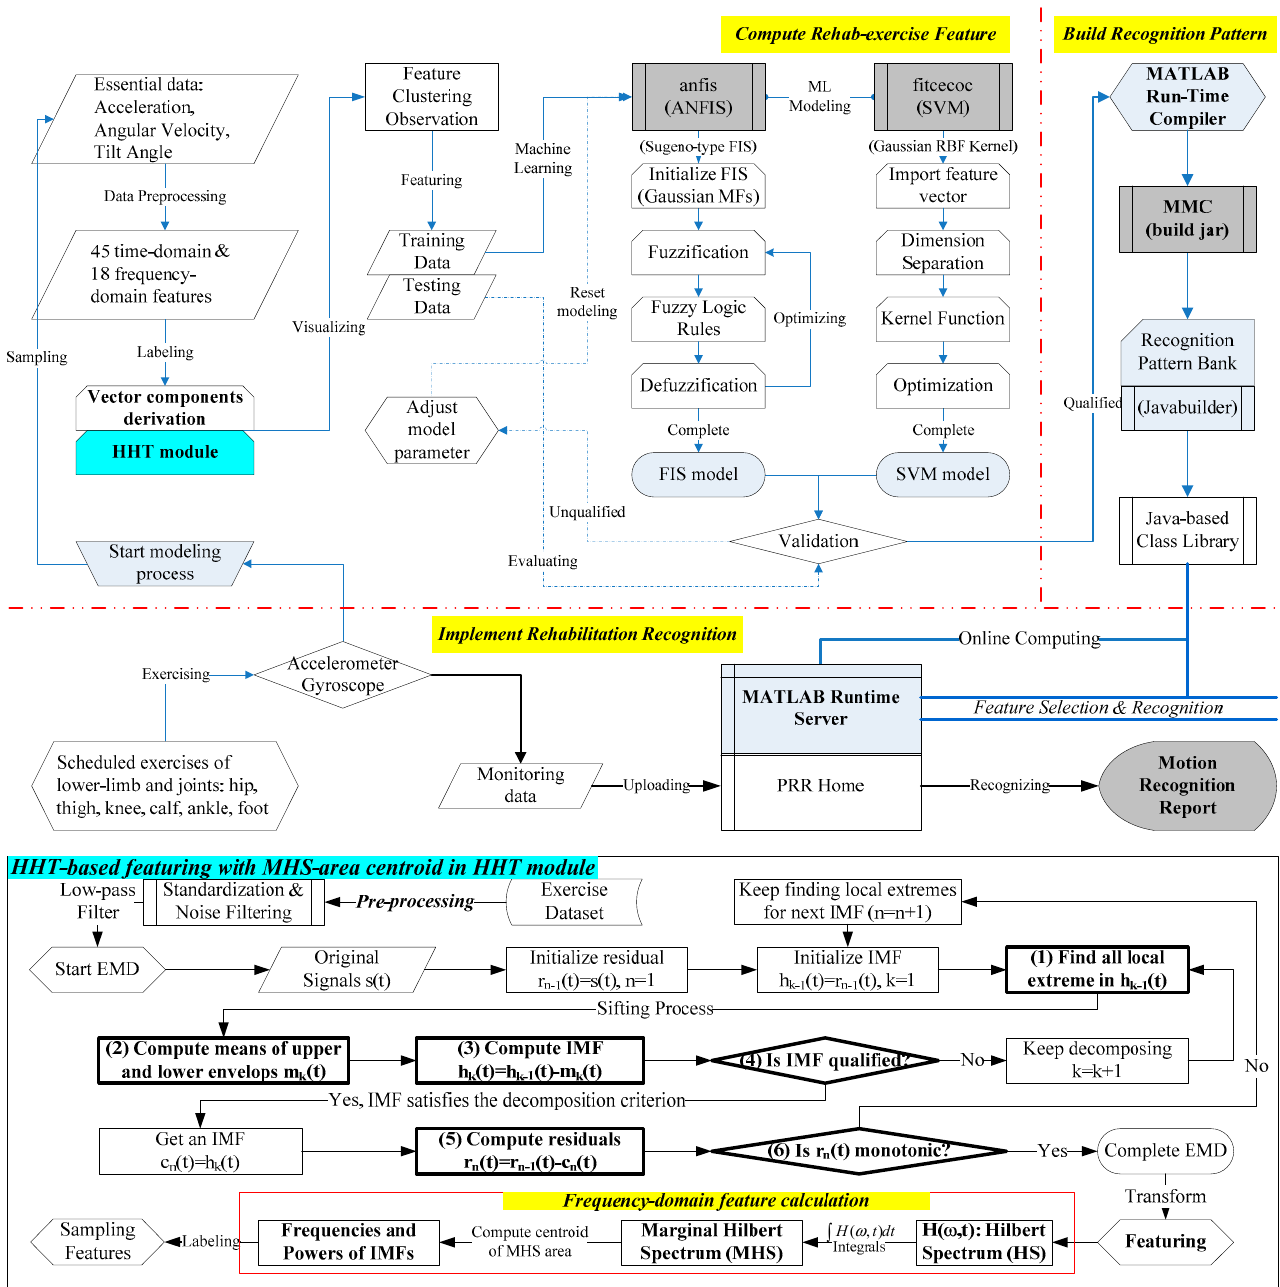
Figure 3. The AI-enabled machine learning and the HHT-based featuring